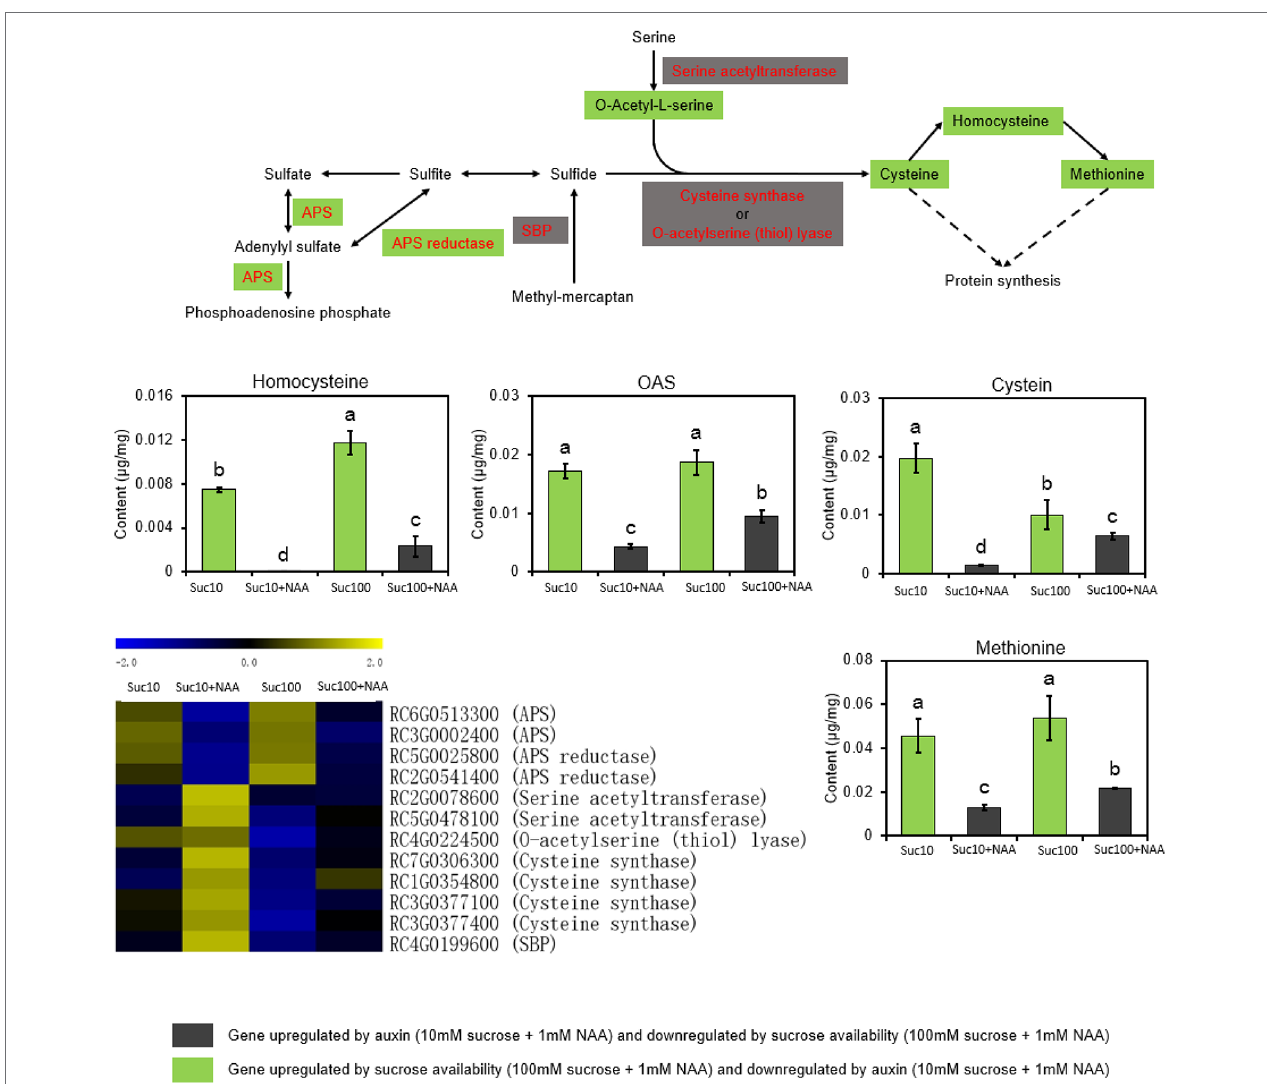
FIGURE 5 | The sulfur metabolism is antagonistically regulated by auxin and sugar in axillary buds. Suc10, 10 mM sucrose; Suc10 + NAA, 10 mM sucrose + 1 μ M NAA; Suc100, 100 mM sucrose; and Suc100 + NAA, 100 mM sucrose + 1 μ M NAA. Dark green labels, enzymes-encoding genes (APS (ATP- sulfurylase) and APR [5 ′ -adenylylsulfate (APS) reductase)] or metabolites (O-acetylserine, cysteine, and homocysteine) repressed by auxin but stimulated by sucrose. Gray labels, enzymes-encoding genes (serine acetyltransferase; cysteine synthase; and selenium-binding protein, SBP) repressed by sucrose but stimulated by auxin. Data are the means ± standard errors (SEs). Letters, significant differences between the different treatments with p < 0.05. Green bars, effect of sucrose alone; gray bars, combined effect of auxin and sucrose. Heatmap color (from blue to yellow), gene transcription level from low to high,